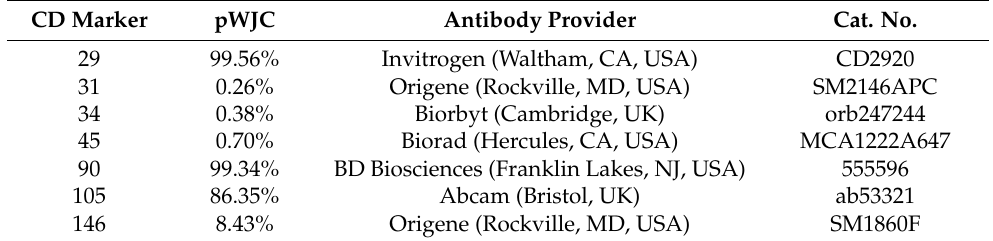
Table 2. Flow cytometry analysis of isolated porcine Wharton ´ s jelly mesenchymal stem cells (pWJCs).